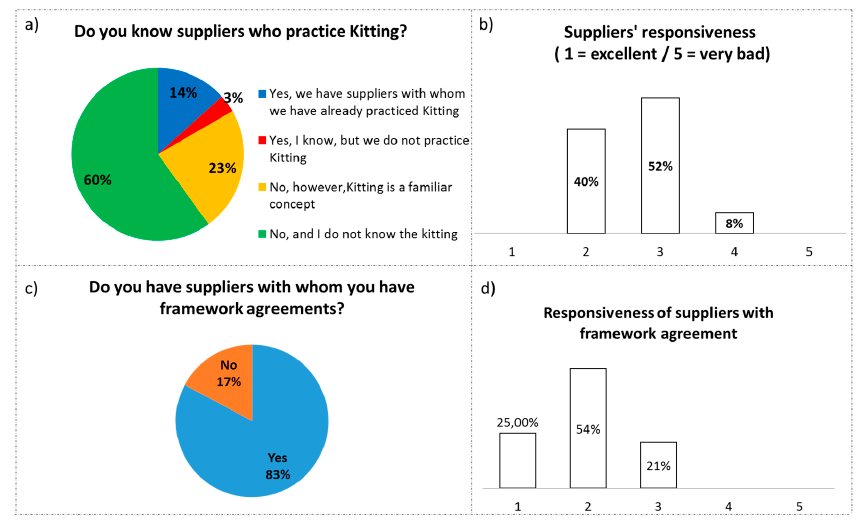
Figure 4. Questions for contractors related to suppliers’ management.